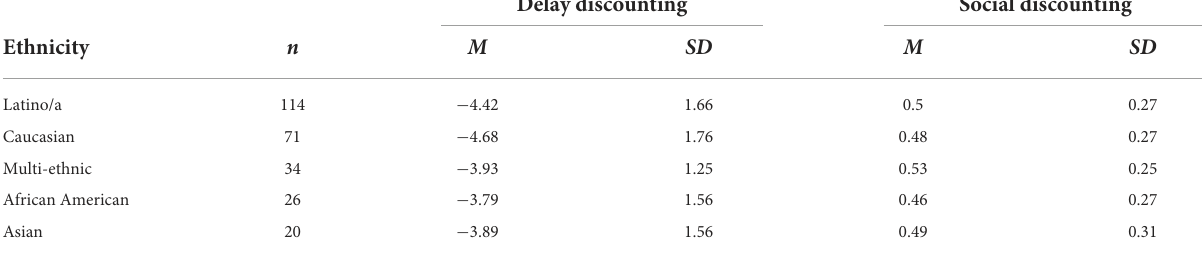
Delay discounting